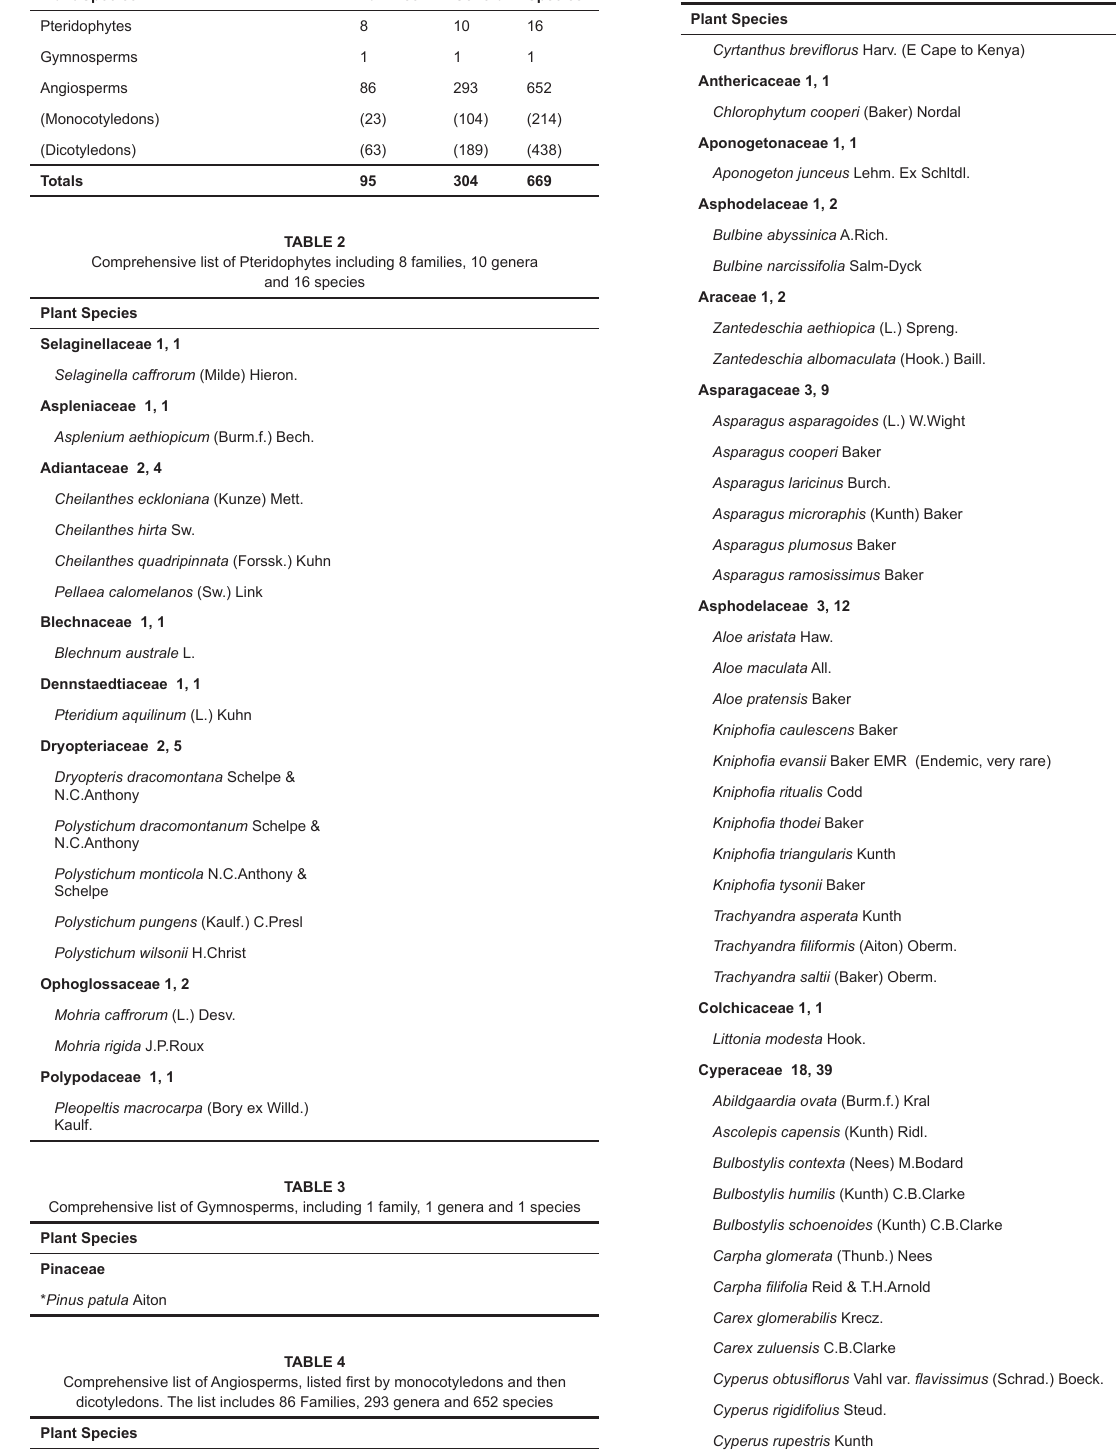
TABLE 4 (Continues...) Comprehensive list of Angiosperms, listed first by monocotyledons and then dicotyle - dons. The list includes 86 Families, 293 genera and 652